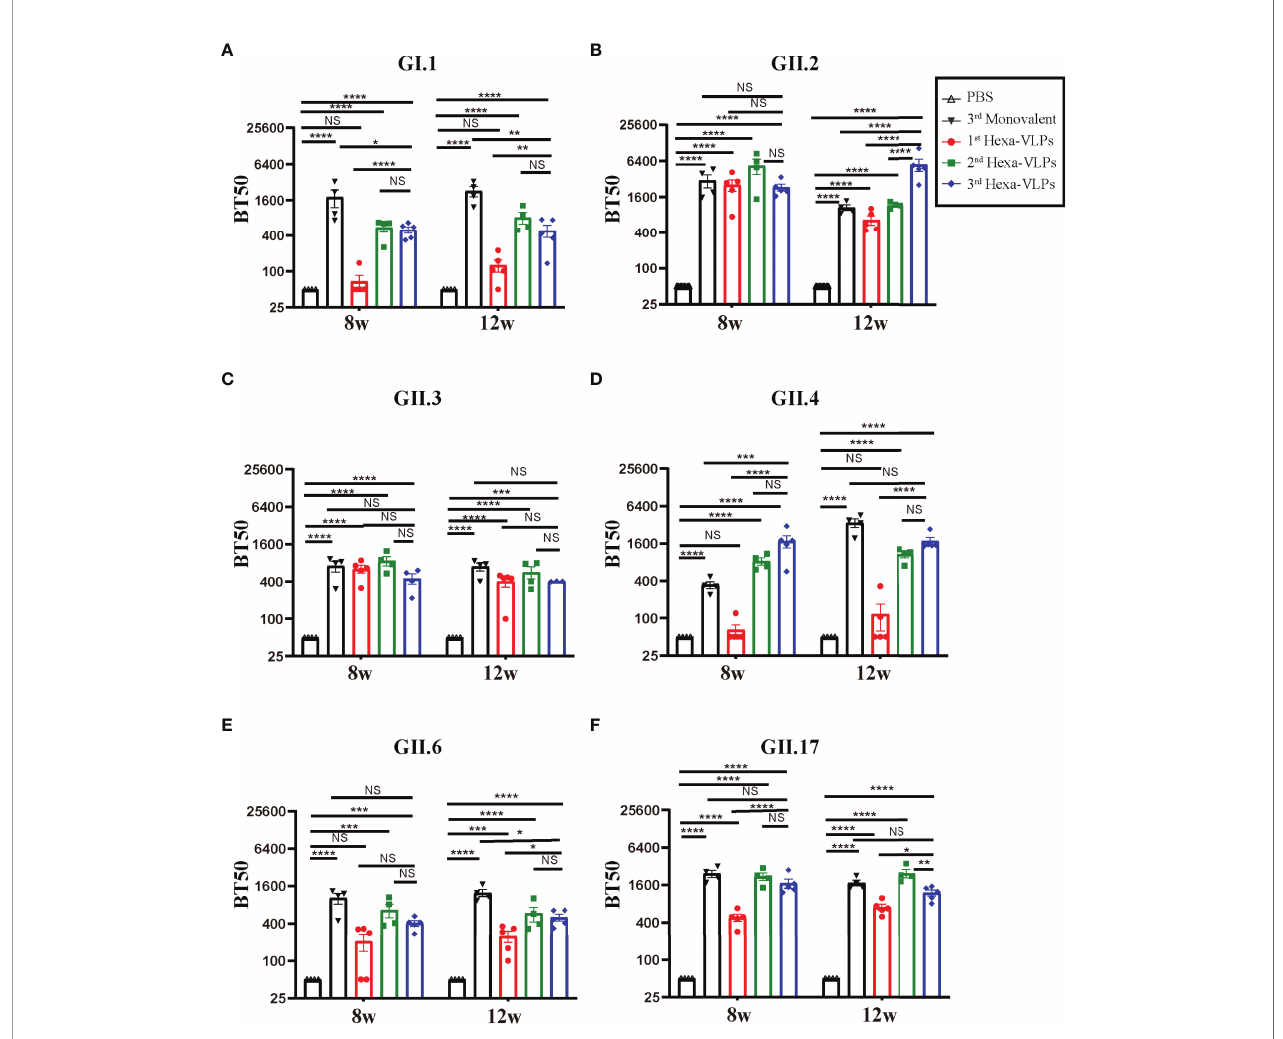
FIGURE 5 | Blockade assay of antisera from different immune regimens. Individual mouse sera collected at 8 w and 12 w were analyzed. Blockade antibody against (A) GI.1, (B) GII.2, (C) GII.3, (D) GII.4, (E) GII.6 and (F) GII.17 VLPs were detected using the VLP-mucin binding blockade assay. BT50 was expressed as the reciprocal of the highest serum dilution blocking 50% of the maximum VLP binding. An arbitrary titer, BT50 of 50, was assigned to samples with <50% blocking index at the lowest serum dilution of 1:100. All data were shown as means ± SEM. Statistical differences were analyzed using one-way ANOVA test with Tukey correction for multiple testing. p < 0.05 (*) was considered statistically signi fi cant; p < 0.01(**); p < 0.001(***); p < 0.0001(****); NS, no signi fi